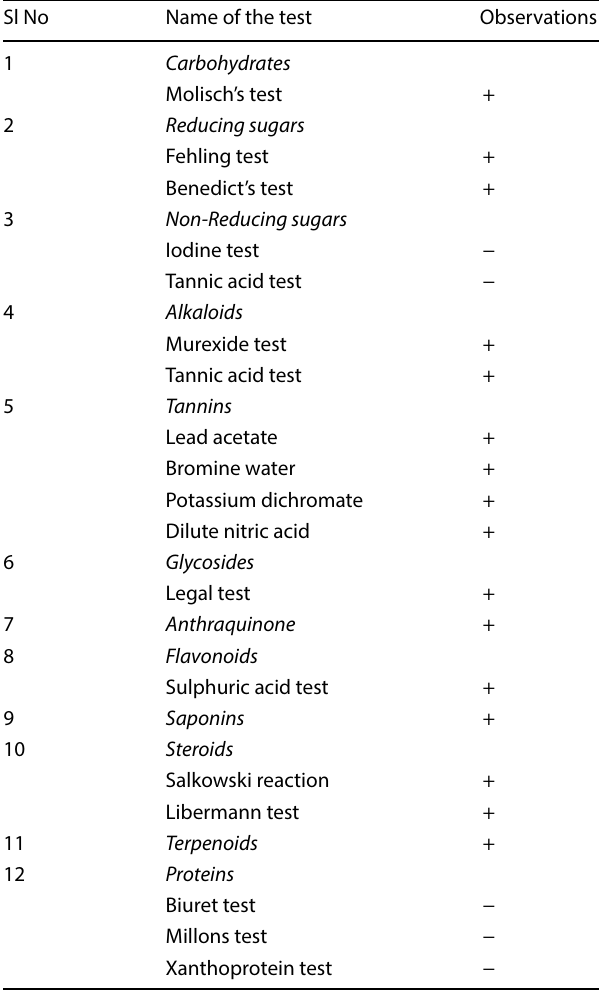
Table 1 Phytochemical screening of epicuticular wax of Euphorbia